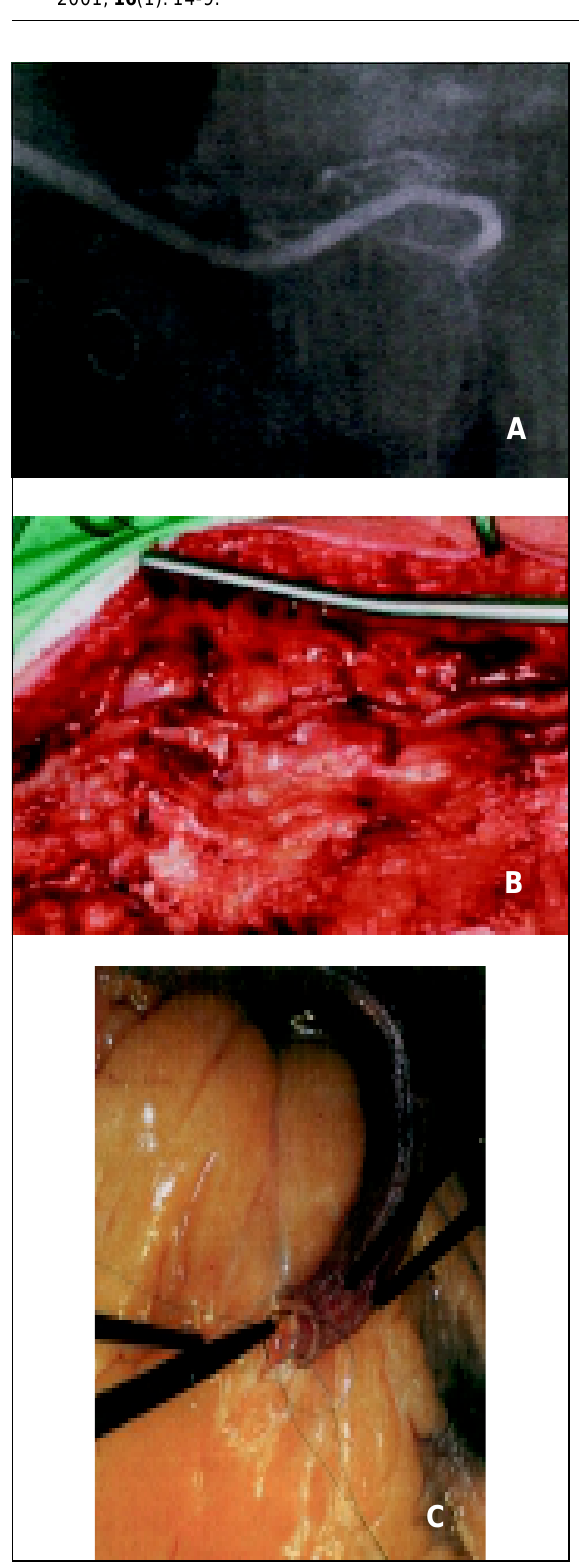
Fig. 1 - Biocompound graft a) vista intraoperatória de veia varicosa dissecada; b) manuseio cirúrgico facilitado; c) controle angiográfico com 12 meses de